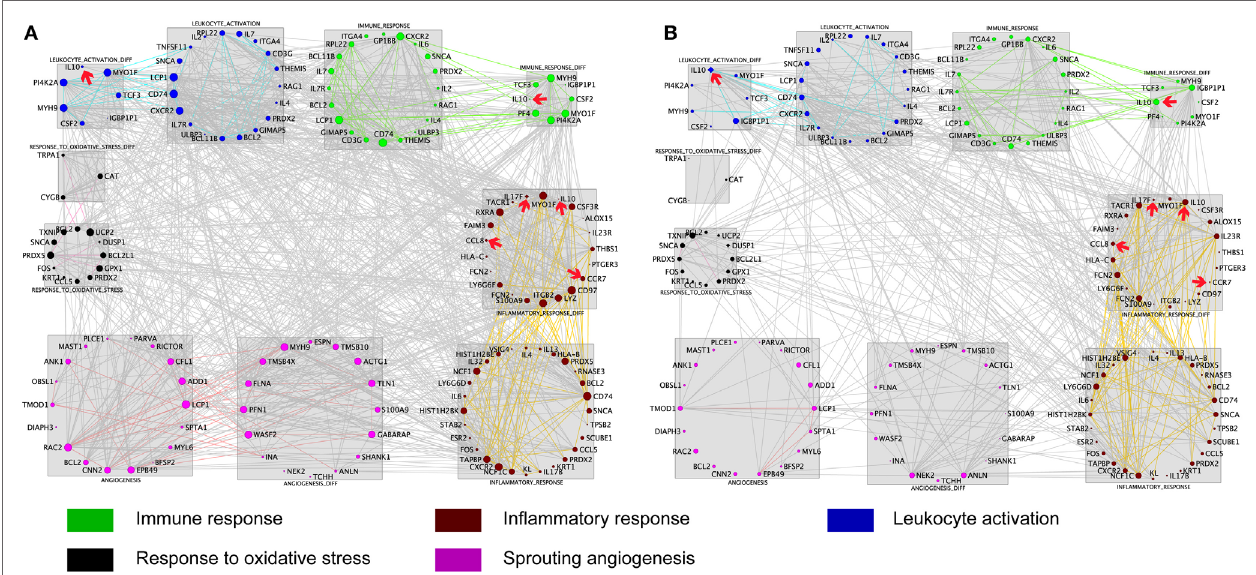
FigUre 3 | cluster visualization identifies acute mountain sickness (aMs)-specific transcriptional regulatory patterns . (a) Connections of differentially expressed genes enriched in five functional clusters that were overrepresented in AMS are depicted. (B) Connections from A that are present in the AMS group but absent in the non-AMS group. Node color represents the enriched biological process. Node size reflects the number of direct connections a gene has within the network. Genes enriched in different clusters are connected by gray lines, and genes enriched in each cluster are connected by colored lines. The cytokines with significant differential connectivity are indicated by red